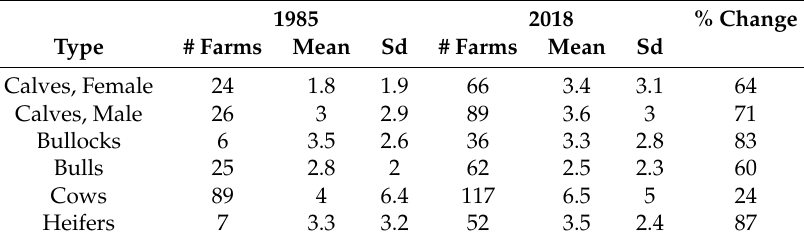
Table 4. Cattle Herd Evolution (N =